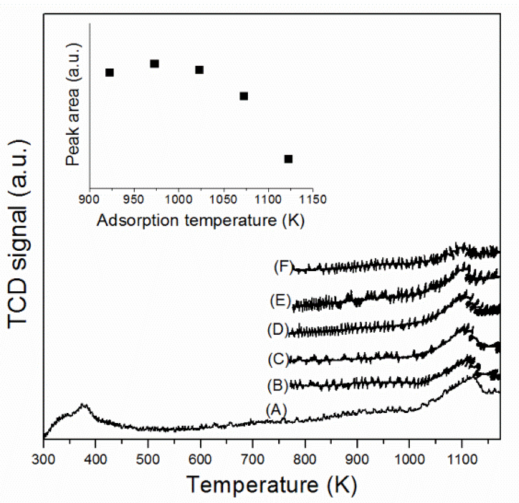
Figure 3. Temperature-programmed desorption of CO 2 for the Mn-Na 2 WO 4 /SiO 2 sample. Experi- ment conditions: heating rate 10 K/min; CO 2 adsorption temperatures: ( A ) 298, ( B ) 923, ( C ) 973, ( D ) 1023, ( E ) 1073 and ( F ) 1123